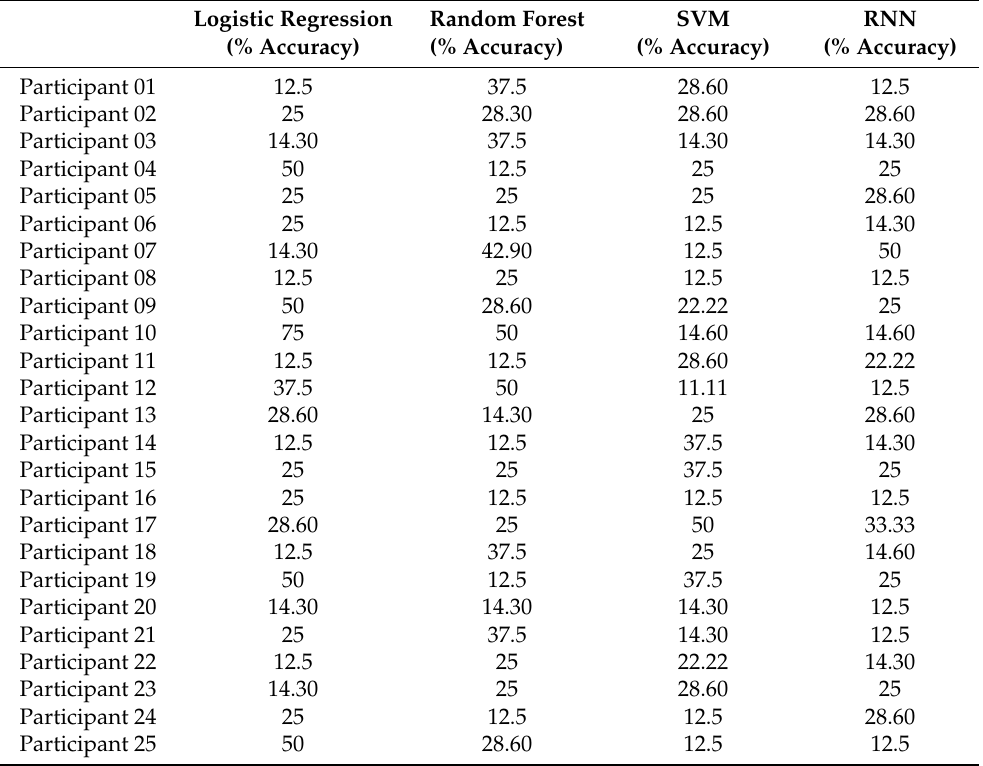
Table A3. Participants of Modified Sternberg Working Memory